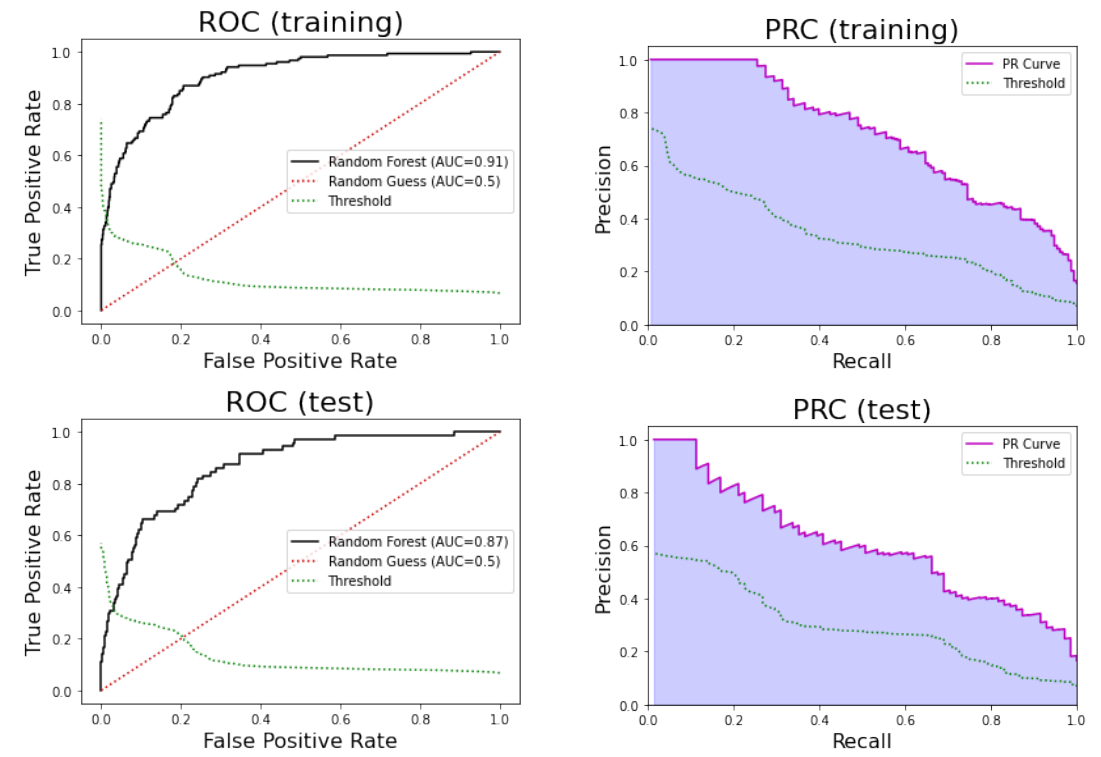
Figure 8. ( Top ) Receiver Operating Curve (ROC) of the random forest model in training ( left ) and Figure 8. Top: Receiver Operating Curve (ROC) of the Random Forest model in training (left) and test testing ( right ). ( Bottom ) Precision-Recall Curve (PRC) in training ( left ) and testing ( right ). (right). Bottom: Precision-Recall Curve (PRC) in training (left) and test (right). For the training set, this model obtained an AUC of 0.87, sensitivity = 0.79, specificity = 0.79, PPV = 0.41, and NPV = 0.95. For the test set, the model obtained an AUC of 0.87, sensitivity = 0.77, specificity = 0.79, PPV = 0.43, and NPV = 0.95. Figure 10 shows the ROC and precision-recall curves for this